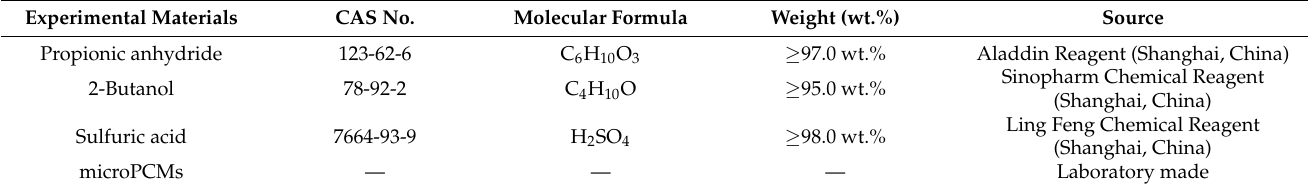
Table 4. Experimental materials used in the temperature control experiments.